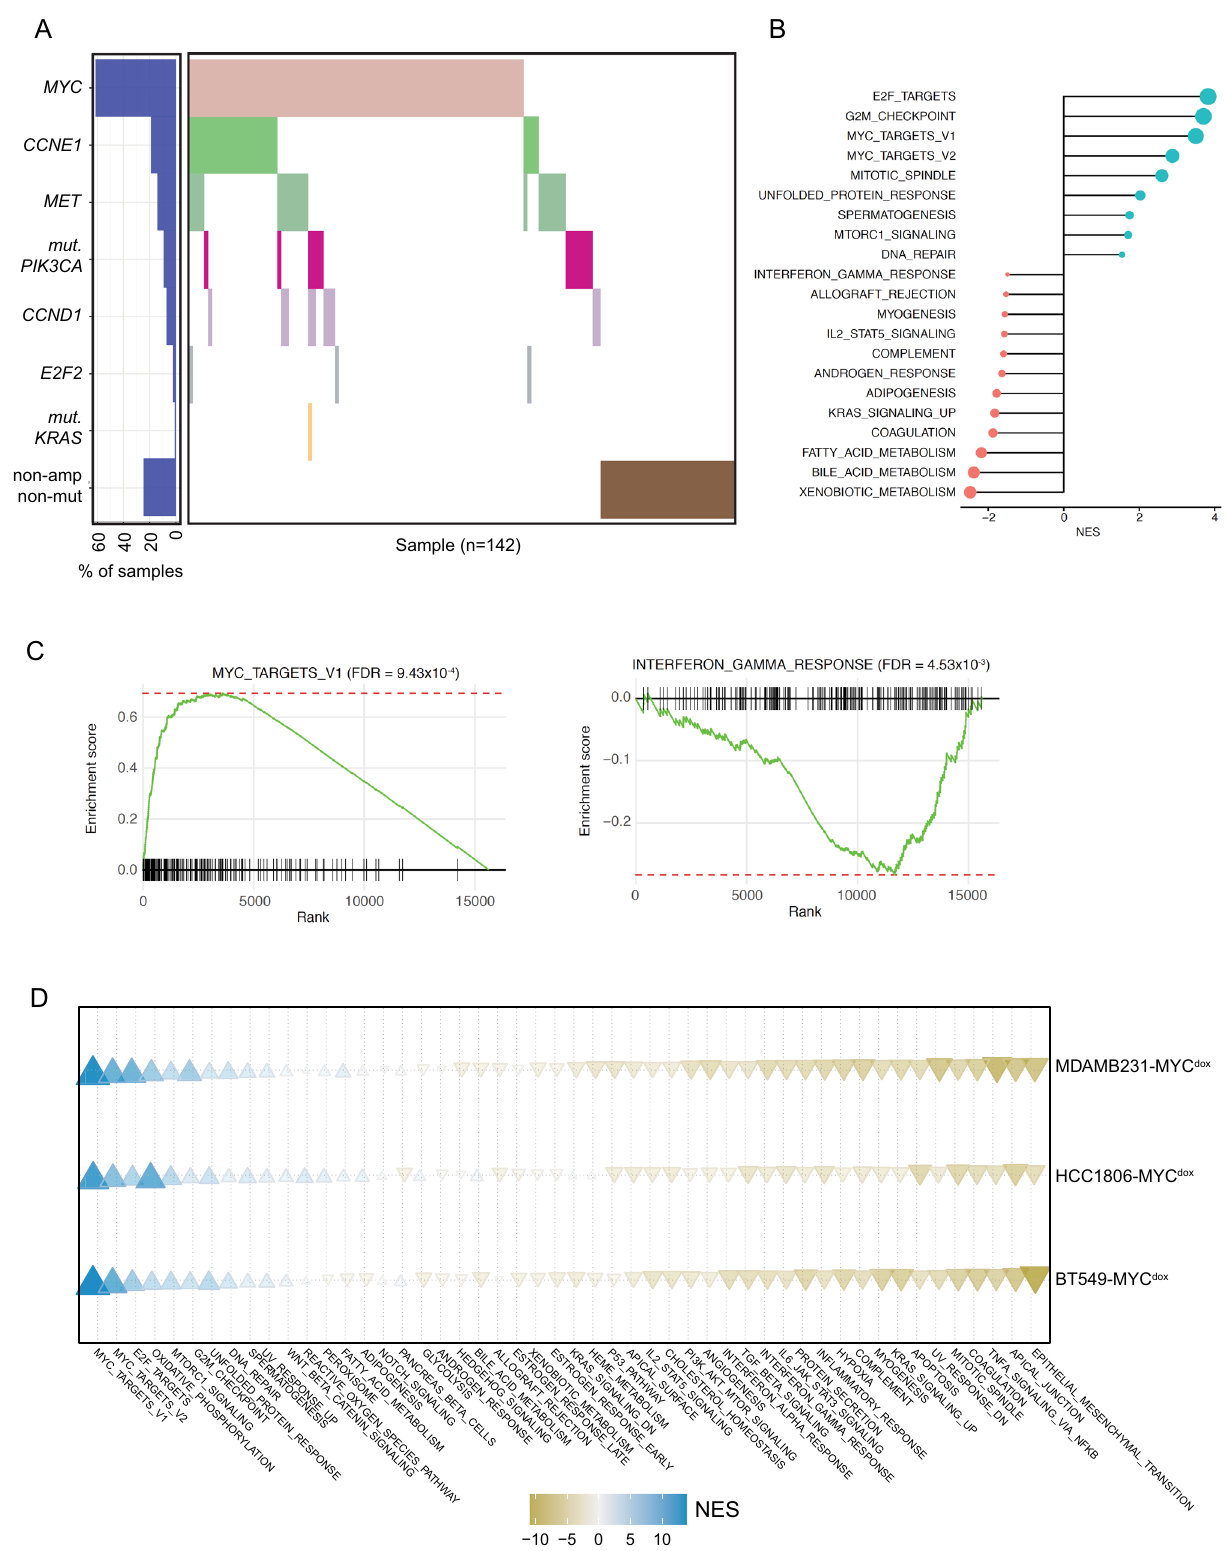
Fig. 1 | MYC expression is associated with downregulation of in fl ammatory pathways in human breast cancer. A Distribution plot of TNBC samples used for GSEA analysisfrom TCGA data.In total,142samples wereincluded in the analyses. Individual samples are plotted on the x-axis. B GSEA for the genes which are positively (cyan) or negatively (pink) correlated with expression of MYC in the TONIC trial dataset. The normalized enrichment scores (NES) for the signi fi cantly enriched gene sets (FDR<0.05) are presented in the bar plot. MsigDB Hallmark